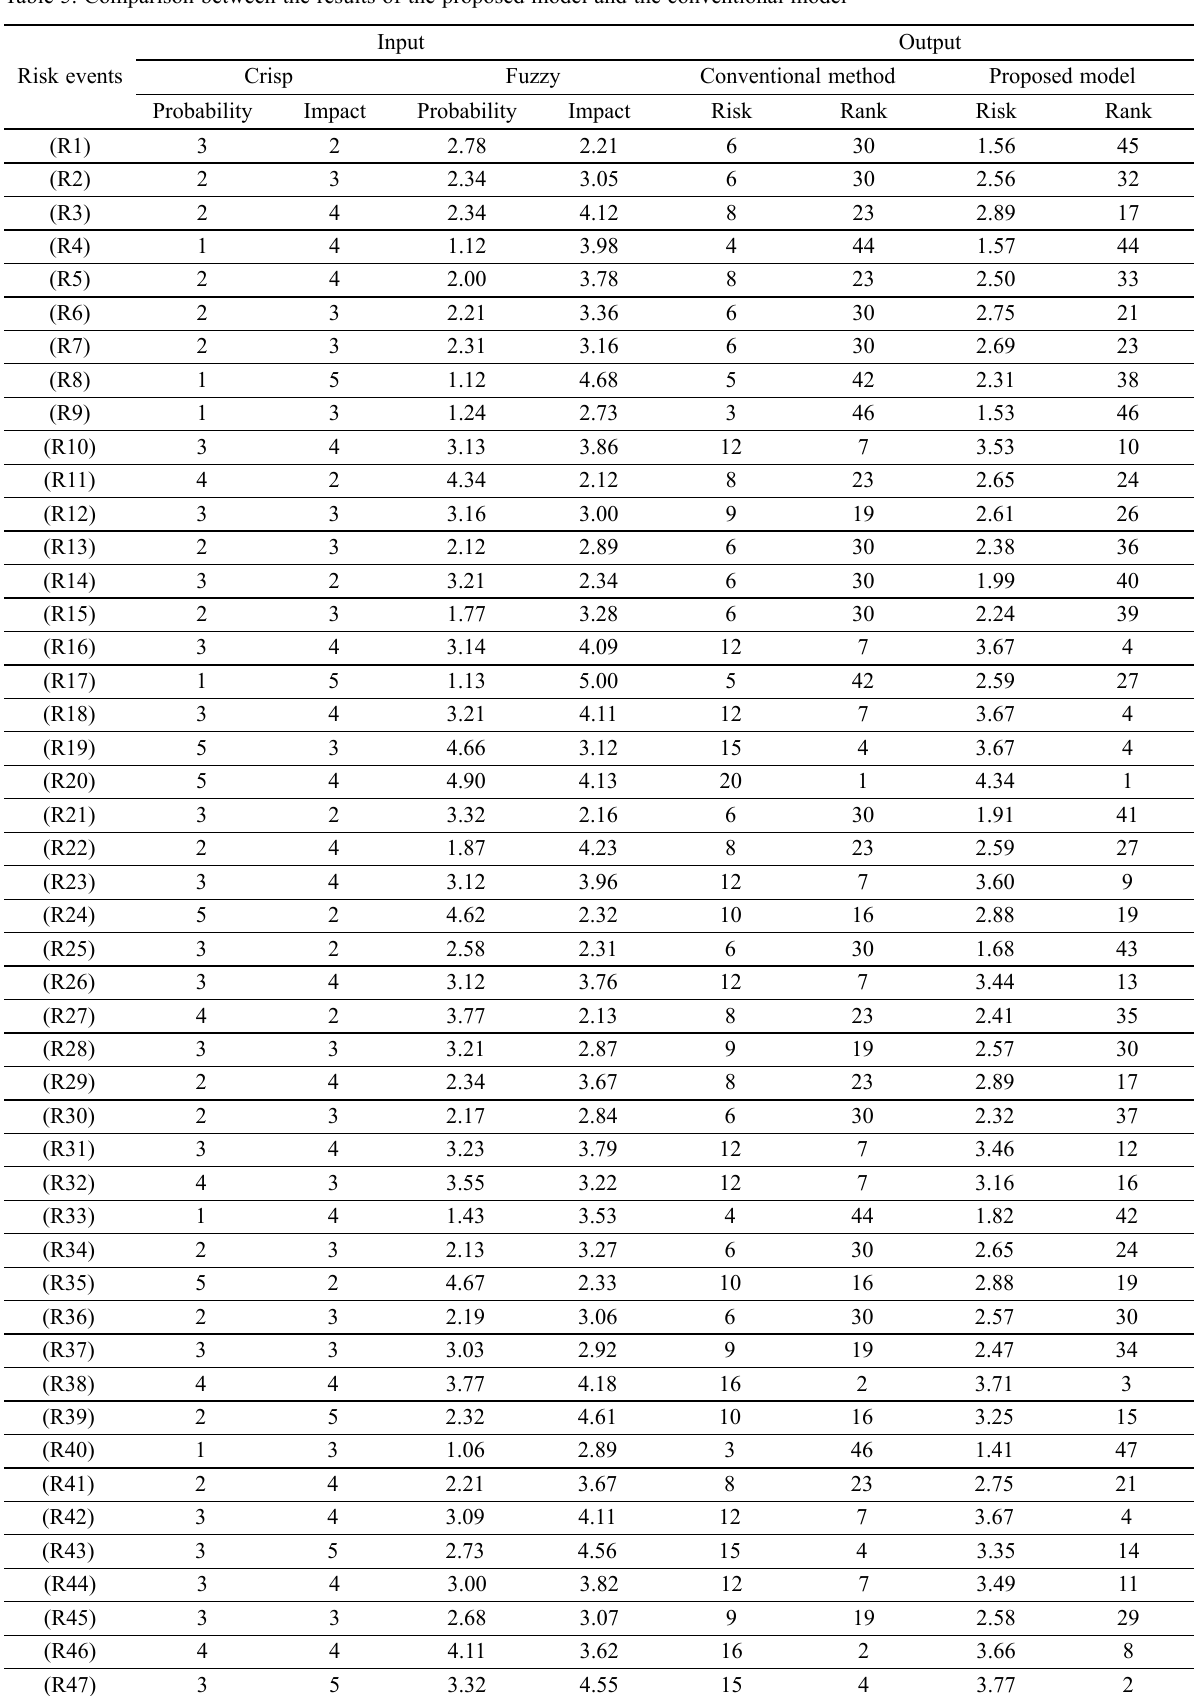
Table 5. Comparison between the results of the proposed model and the conventional model Input Output Risk events Crisp Fuzzy Conventional method Probability